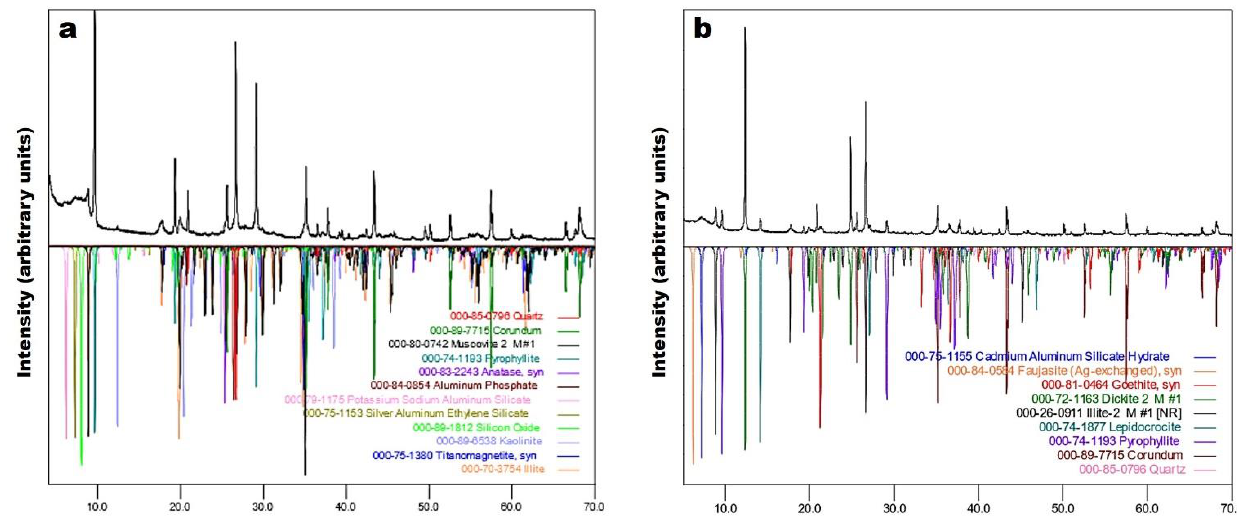
Figure 4. XRD pattern of the analyzed ( a ) mudstone and ( b ) regolith. Qtz: Quartz; Ms: Muscovite; Pyr: Pyrophyllite; Lpd: Lepidocrocite; Kao: Kaolinite; Dck: Dickite; Ill: Illite; Goe: Goethite; TiMag: Titanomagnetite; LTA: Na-A zeolite; FAU: Faujasite; SSZ: Zeolite SSZ-35.